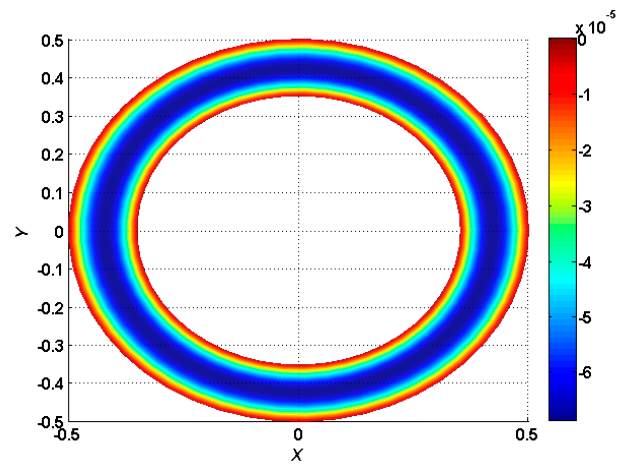
Figure 11. Normalized maximum deflection w ∗ = wE Al h 3 / q , with torus R h = 0.7 and fully clamped boundary conditions under a transverse uniform load q .